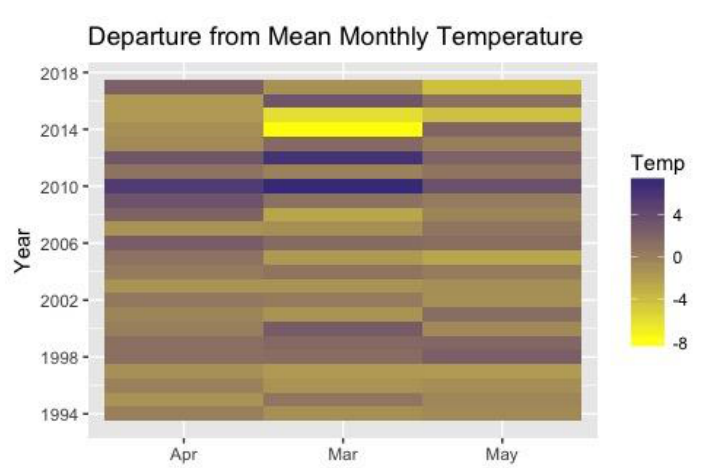
Figure 3. Heat map of departure from mean of spring-time monthly temperatures over the course of the study. Temperature is given in °F.